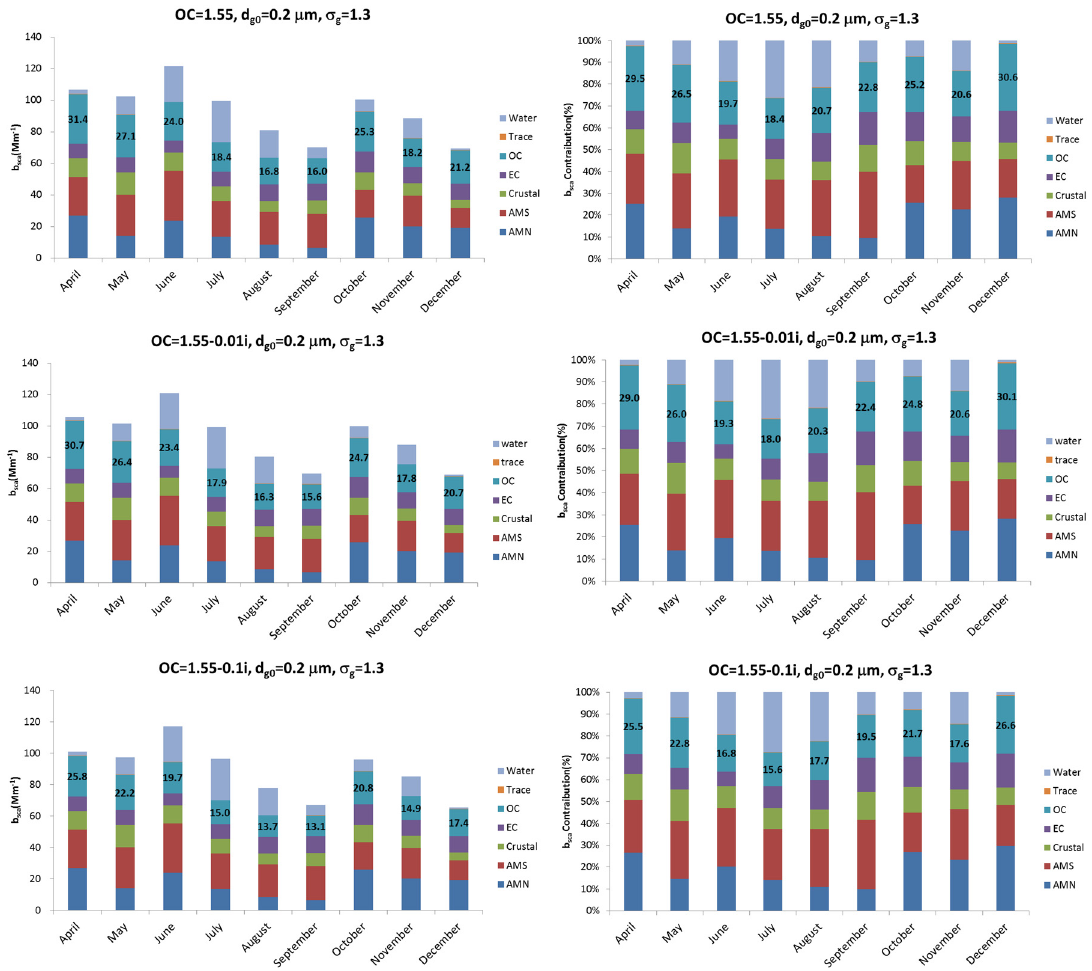
Figure 5. Comparison of the monthly averaged scattering coefficient and scattering coefficient contribution between different refractive indices of organic carbon ( λ = 550 nm).